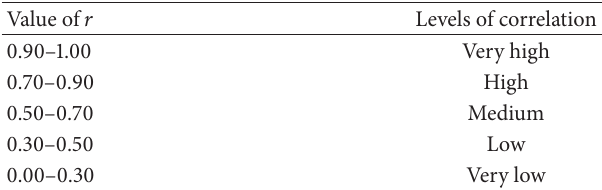
Table 3: Levels of correlation